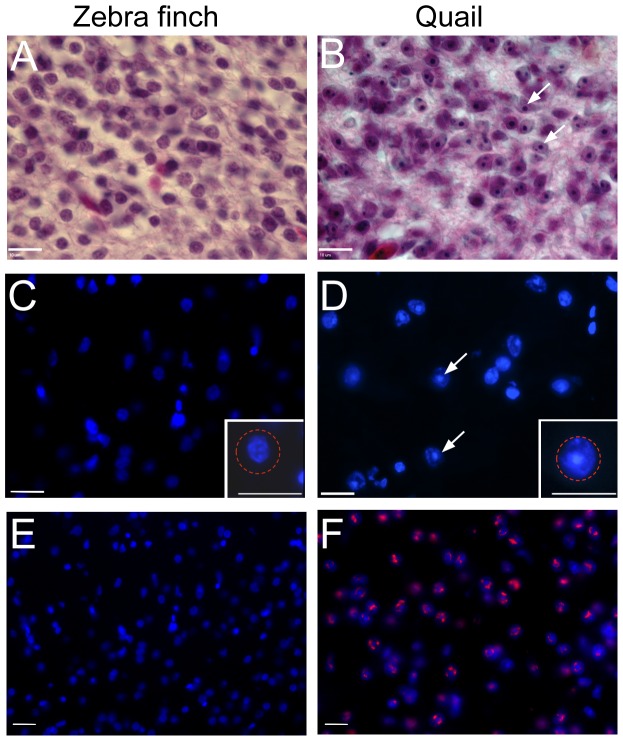
Cell histology differences between quail and zebra finch using three staining methods.(A–B) Hematoxylin and eosin (HE) staining of nuclei in normal zebra finch (A) and quail (B) brain tissue. Arrows point to nucleoli, and show the condensed heterochromatin in the center of the nucleus associated with the nucleolus of the quail cells. (C–D) DAPI staining (blue) in zebra finch (C) and quail (D). Arrows point to nucleoli in the quail cells. Higher magnification of an example of a single zebra finch and quail cell is in the right bottom corner inset of C and D, respectively. The red circle in C is identical in size to the red circle in D, illustrating the nucleus size difference between species. QCPN, quail-specific antibody stains only quail cells (red in F), not zebra finch cells (E) counter stained with DAPI (blue). Scale bar = 10 µm.